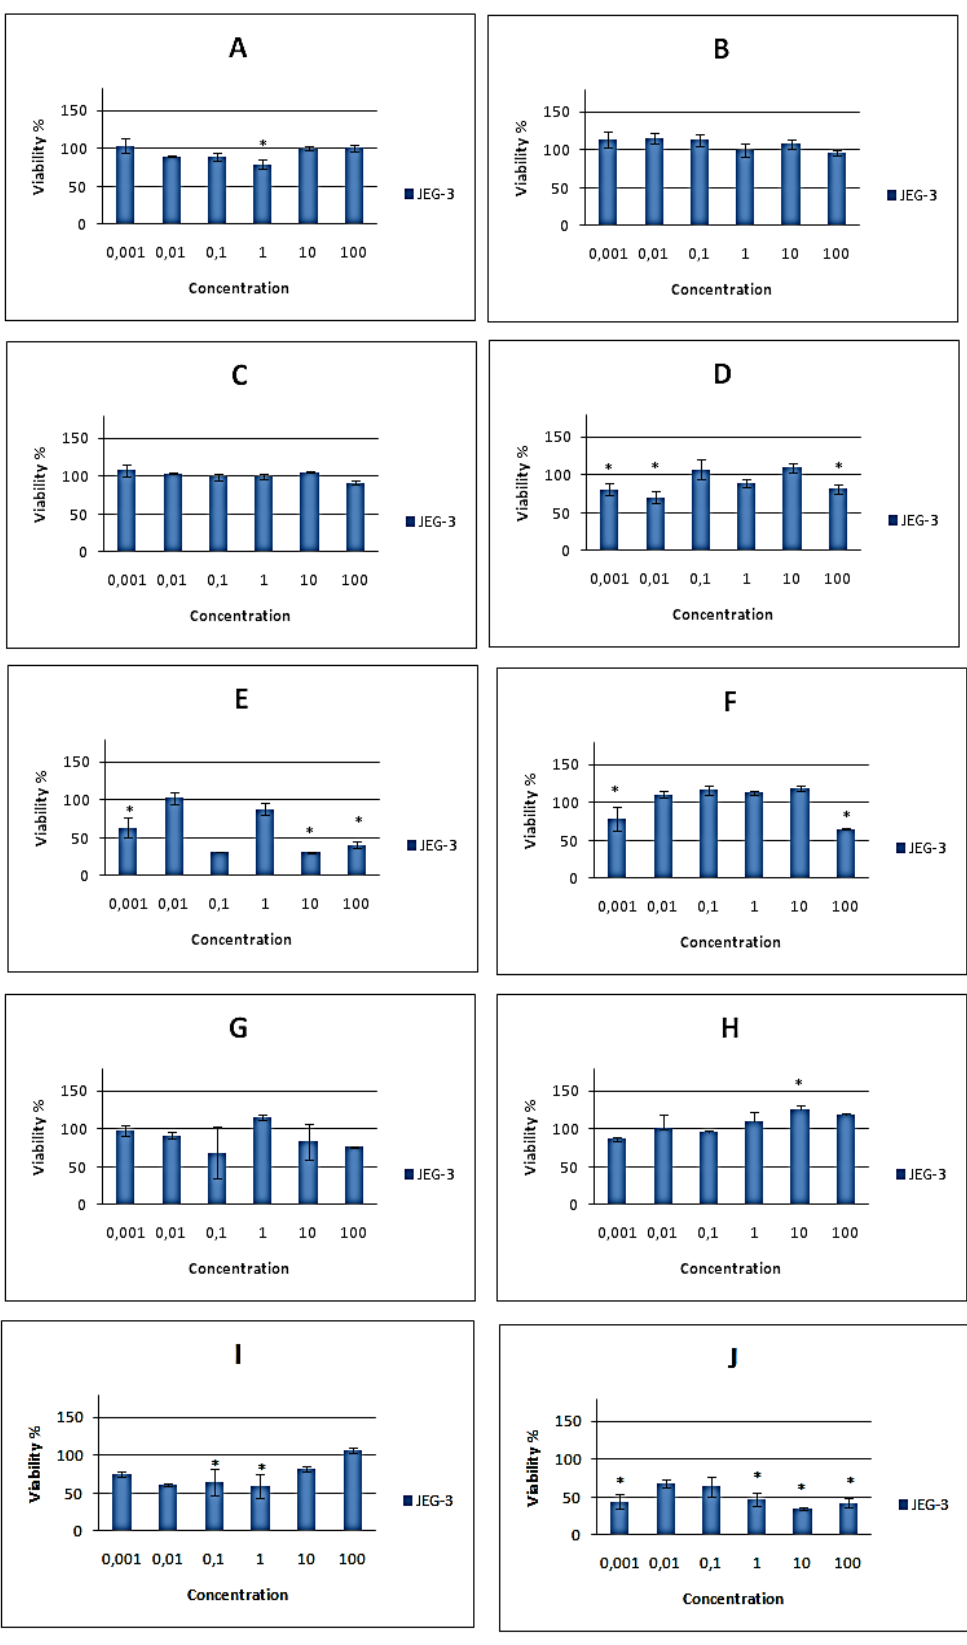
Figure 3. Effects of long-term (72 h) treatment of different concentrations of steroidal imidazoheterocycles on JEG-3 choriocarcinoma cell